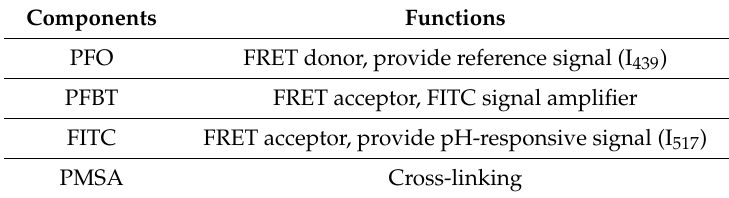
Table 1. The composition of Pdots-PPF and the roles of each